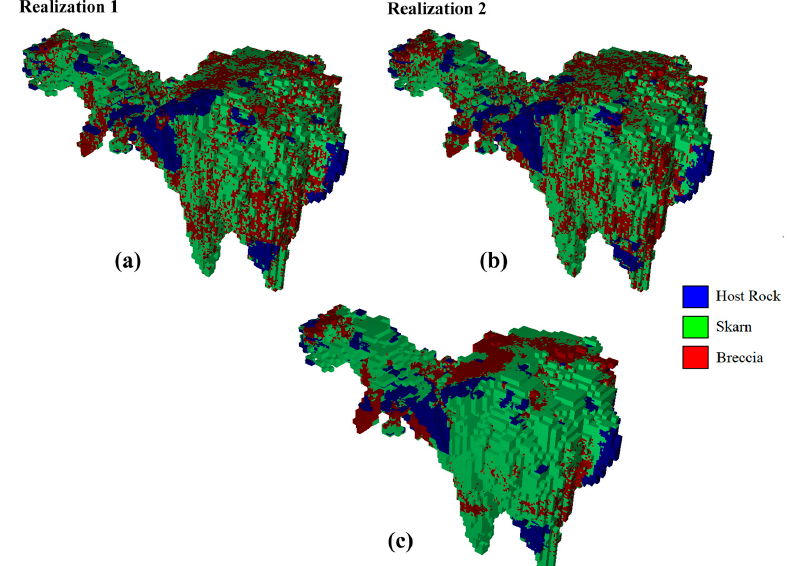
Figure 4. ( a , b ) Two plurigaussian realizations of rock types conditioned to drill hole data. ( c ) Most probable rock type, i.e., the most frequent rock type over the realizations. White areas correspond to grid nodes above the topographic surface or outside the sampled region.